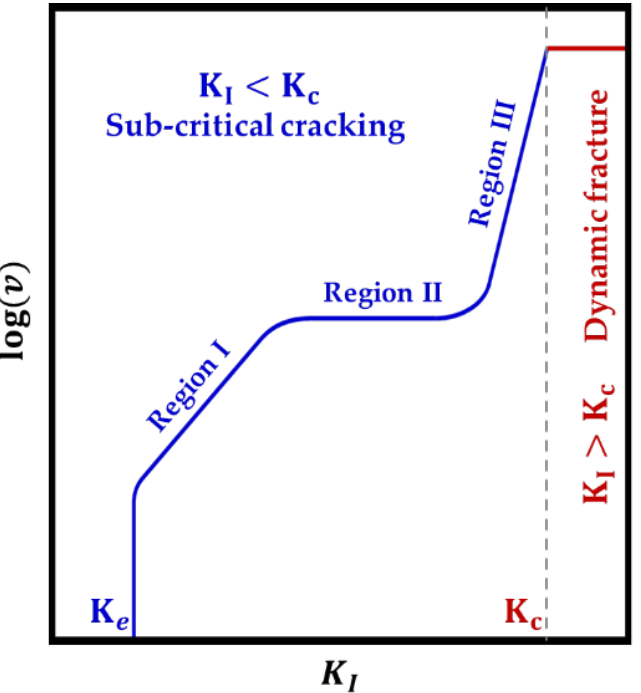
) as a function of the stress intensity factor ( ) ) [3,4,7] Recreated with permission log( 𝑣𝑣 ) 𝐾𝐾 𝐼𝐼 𝐾𝐾 𝐼𝐼 < 𝐾𝐾 𝑐𝑐